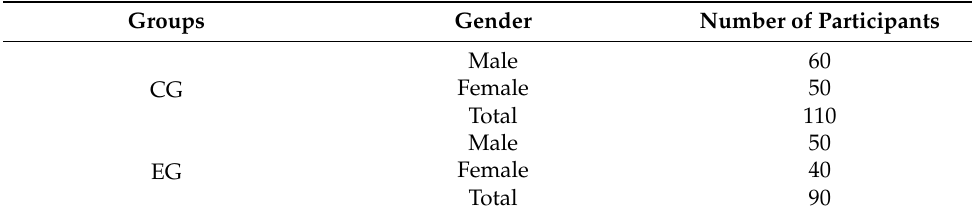
Table 1. Descriptive Data of Samples. Groups